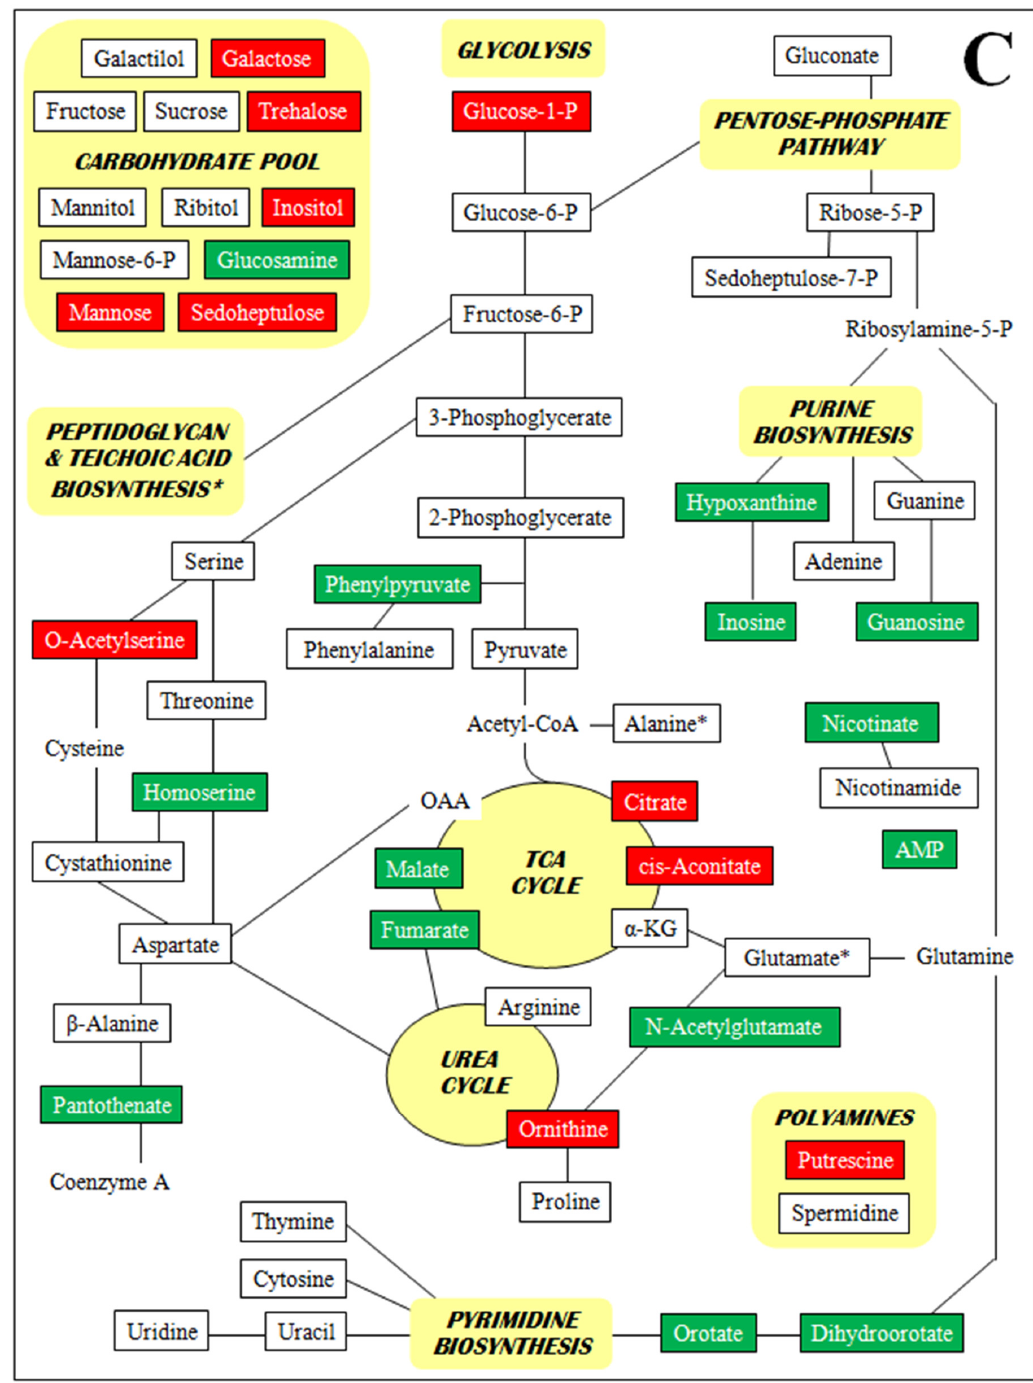
Figure 2. Metabolites with at least one five-fold relative concentration difference between ( A ) VISA 13136p − m + V5 relative to VSSA 13136p − m + , ( B ) VISA 13136p − m + V20 relative to VSSA 13136p − m + and ( C ) VISA 13136p − m + V20 relative to VISA 13136p − m + V5, as well as their positions in metabolic pathways. Bordered terms: metabolites identified by metabolomic analyses; green shading: five-fold or greater relative concentration increases; red shading: five-fold or greater relative concentration